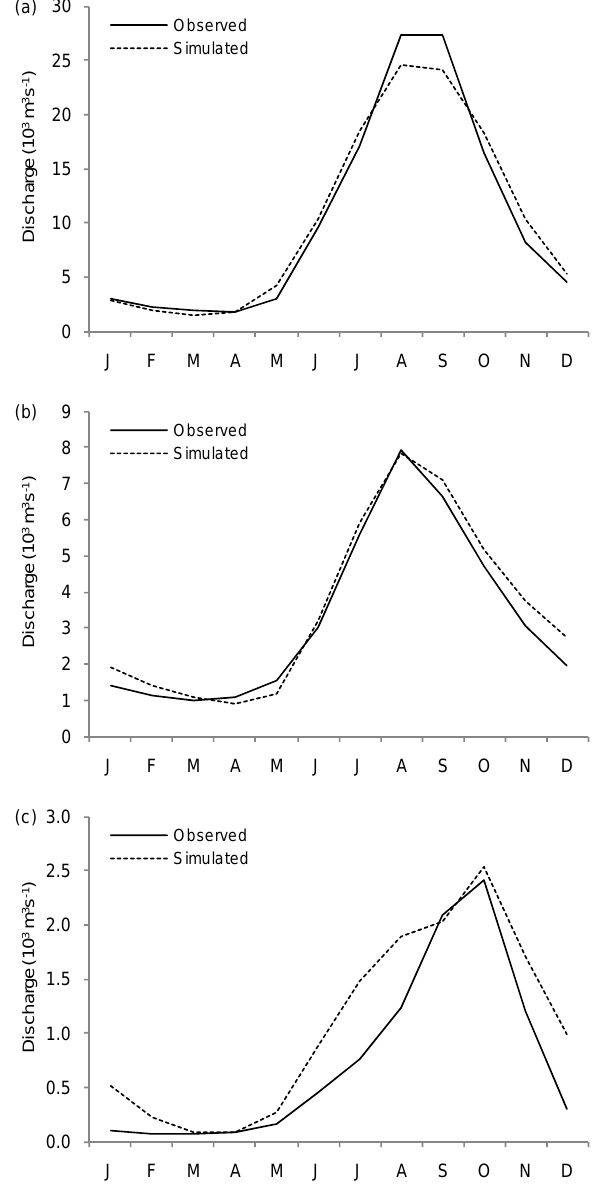
Fig. 2. Observed and simulated mean monthly discharges (1961– 1990): (a) Mekong at Pakse (Mekong 2), (b) Lancang sub-basin at Chiang-Saen, (c) Chi-Mun sub-basin at Ubon (note varying y-axis